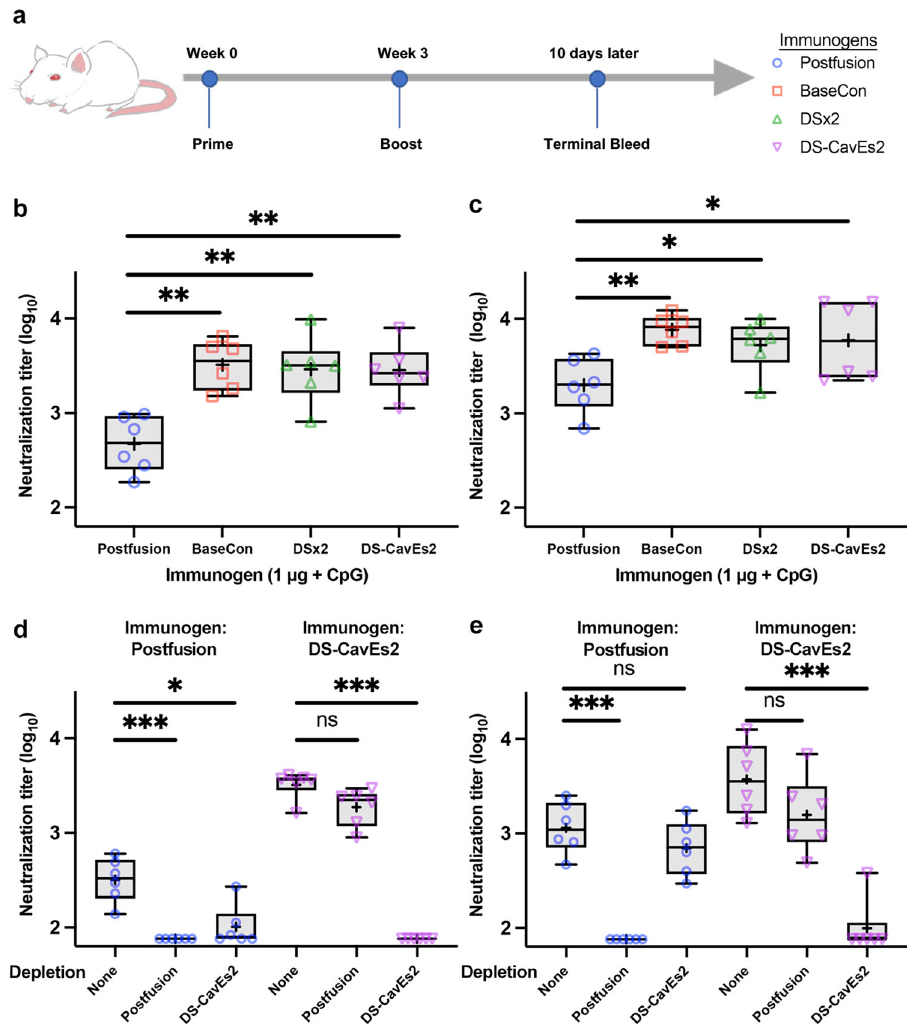
Fig. 6 Prefusion-stabilized hMPV F variants elicit neutralizing antibodies in mice. a 8-week-old male BALB/c mice ( n = 6/group) were immunized at weeks 0 and 3 with 1 μ g of prefusion-stabilized hMPV F variants or heat-treated postfusion hMPV F, all adjuvanted with CpG. b , c 10 days after the week 3 injection, mice were bled for analysis of serum neutralization titers against hMPV b A1 and c B1 viruses. Each point represents an individual mouse (blue circle, postfusion; orange square, prefusion base construct, BaseCon; green triangle, DSx2; purple inverted triangle, DS-CavEs2). All box plots show mean as a plus sign, median as a central line, 25 and 75% as lower and upper box limits, and minimum to maximum values as whiskers. Each experimental group was compared with the postfusion-immunized group using one-way ANOVA. * = p -value < 0.05, ** = p -value < 0.01. For b , postfusion vs. BaseCon, p = 0.0029; postfusion vs. DSx2, p = 0.0055; postfusion vs. DS-CavEs2, p = 0.0062. For c , postfusion vs. BaseCon, p = 0.0051; postfusion vs. DSx2, p = 0.0454; Postfusion vs. DS-CavEs2, p = 0.0169. d , e The sera from immunized mice were depleted with 1 μ g of postfusion or DS-CavEs2 proteins prior to the analysis of serum neutralization titers against hMPV d A1 and e B1 viruses. Serum depletion groups were compared with the non-depletion group using one-way ANOVA. ns = no signi fi cant, * = p-value < 0.05, *** = p-value < 0.005. For d and postfusion immunized sera, non-depletion vs. postfusion, p = 0.0004; non-depletion vs. DS-CavEs2, p = 0.0179. For d and DS-CavEs2 immunized sera, non-depletion vs. postfusion, p = 0.2461; non-depletion vs. DS-CavEs2, p = 0.0004. For e and postfusion immunized sera, non-depletion vs. postfusion, p = 0.0006; non-depletion vs. DS-CavEs2, p = 0.3489. For e and DS-CavEs2 immunized sera, non-depletion vs. postfusion, p = 0.2742; non-depletion vs. DS-CavEs2, p = 0.0005. Source data are provided as a Source Data fi le for panels b – e